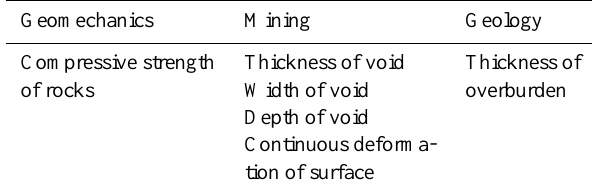
Table 1. Quantitative risk